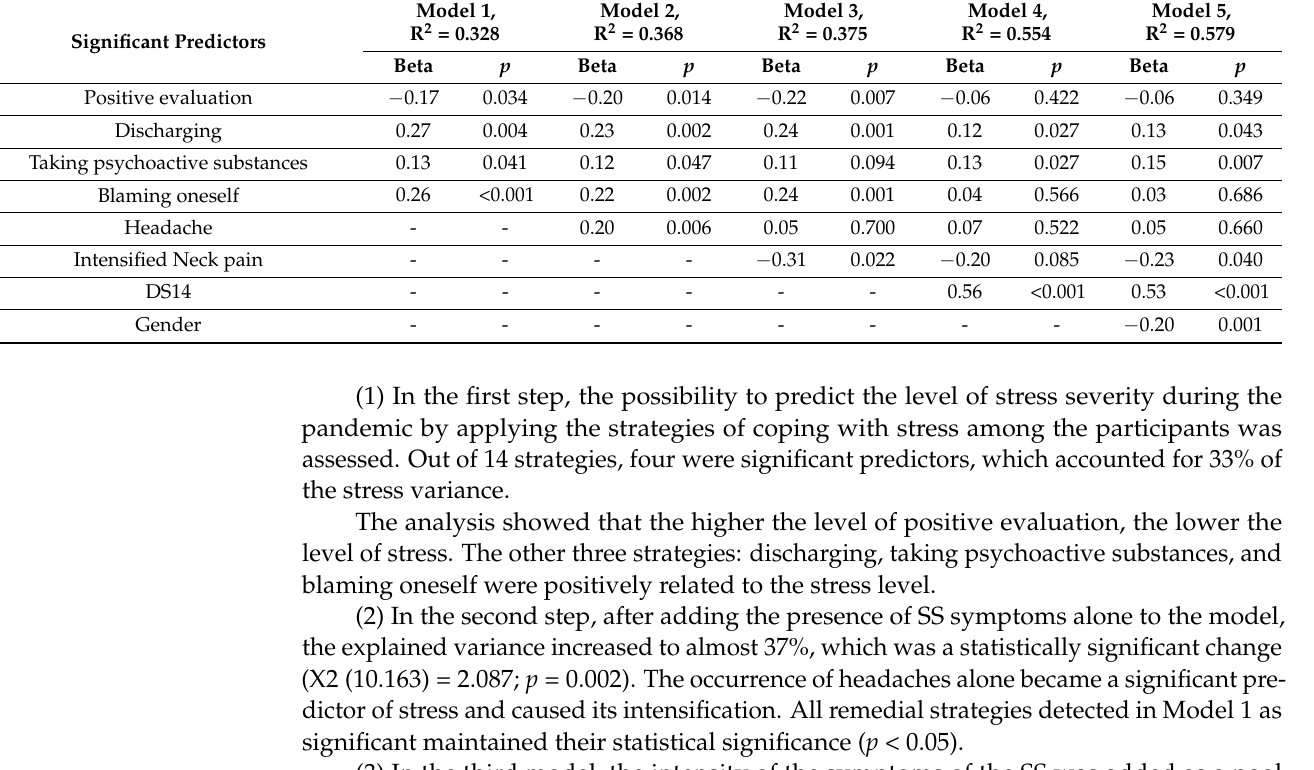
Significant Predictors Positive